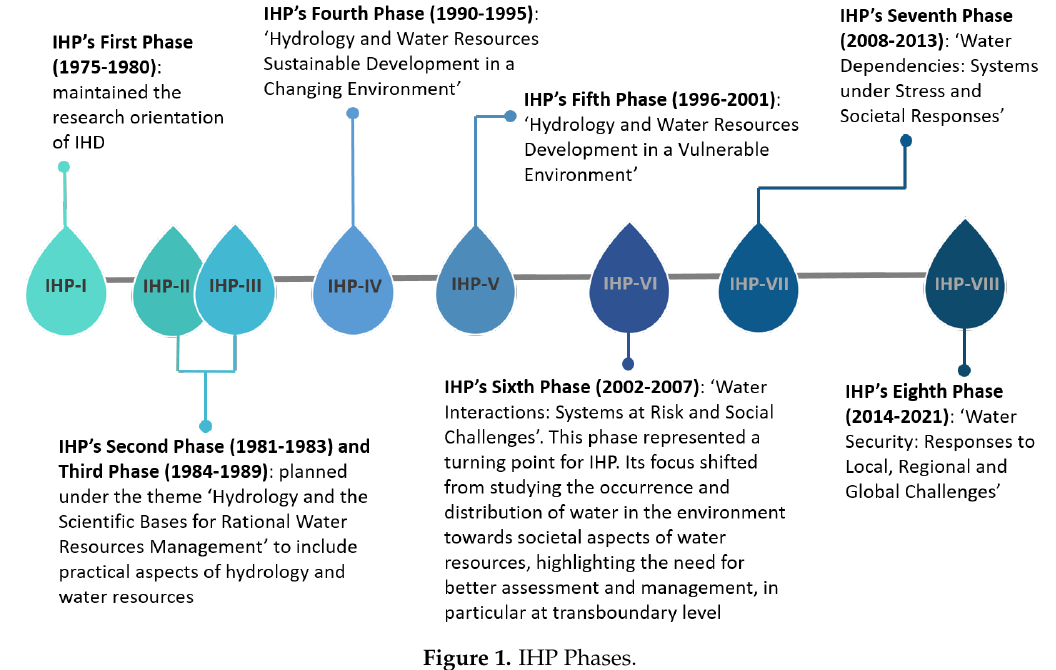
Figure 1. IHP Figure 1. IHP Phases.